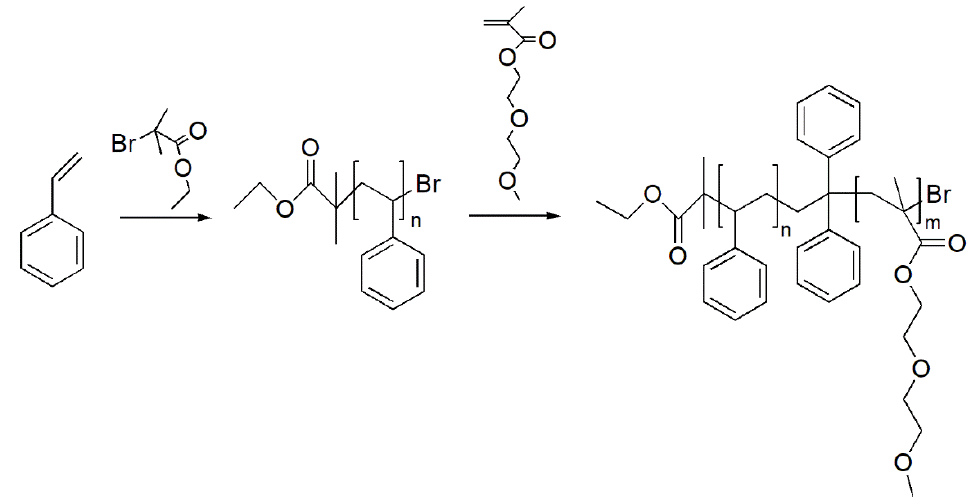
Figure 3. Reaction scheme of synthesis of the PS-b- PDMEEMA block-copolymer by ATRP.